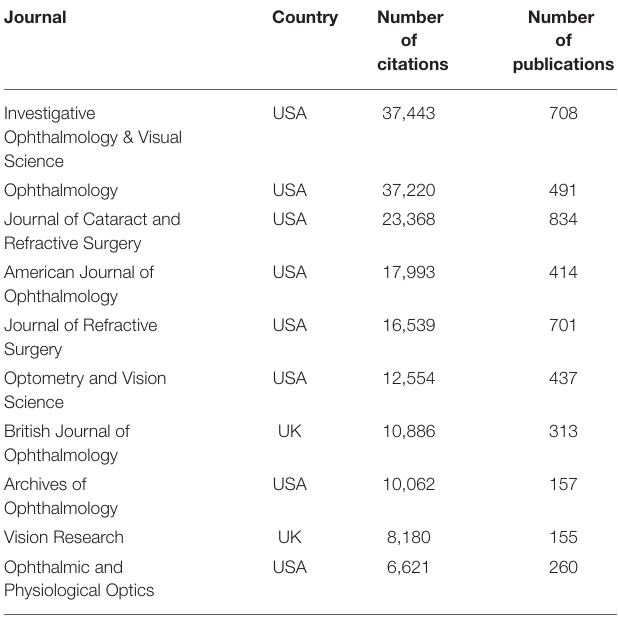
TABLE 3 | Top 10 influential source journals for myopia